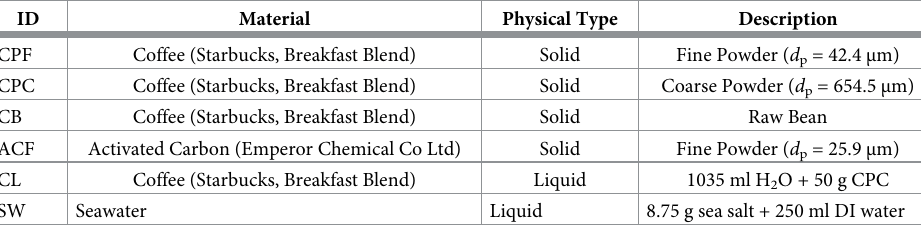
Table 2. The information of the materials under test, where d p is the volume weighted mean